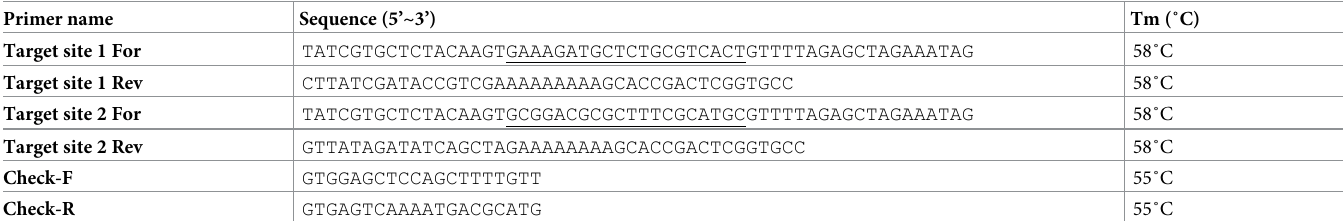
Table 2. Primers used for RT-qPCR